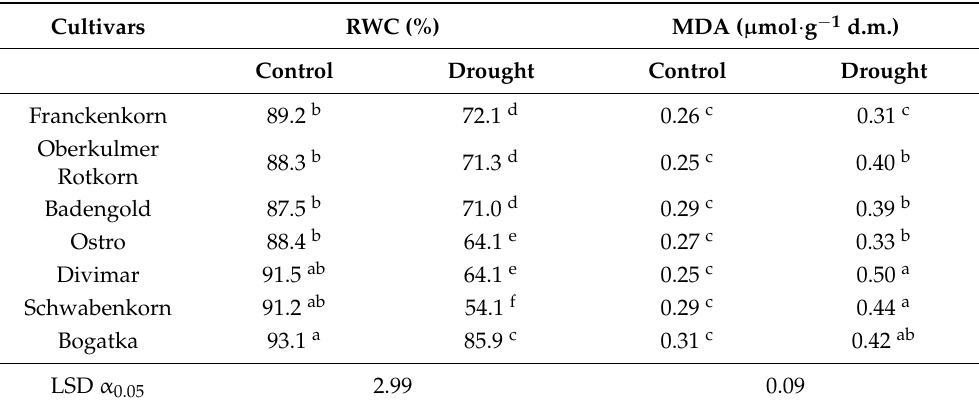
Table 2. Effect of wheat cultivars and drought stress on the Relative Water Content (RWC) and Lipid Peroxidation Index